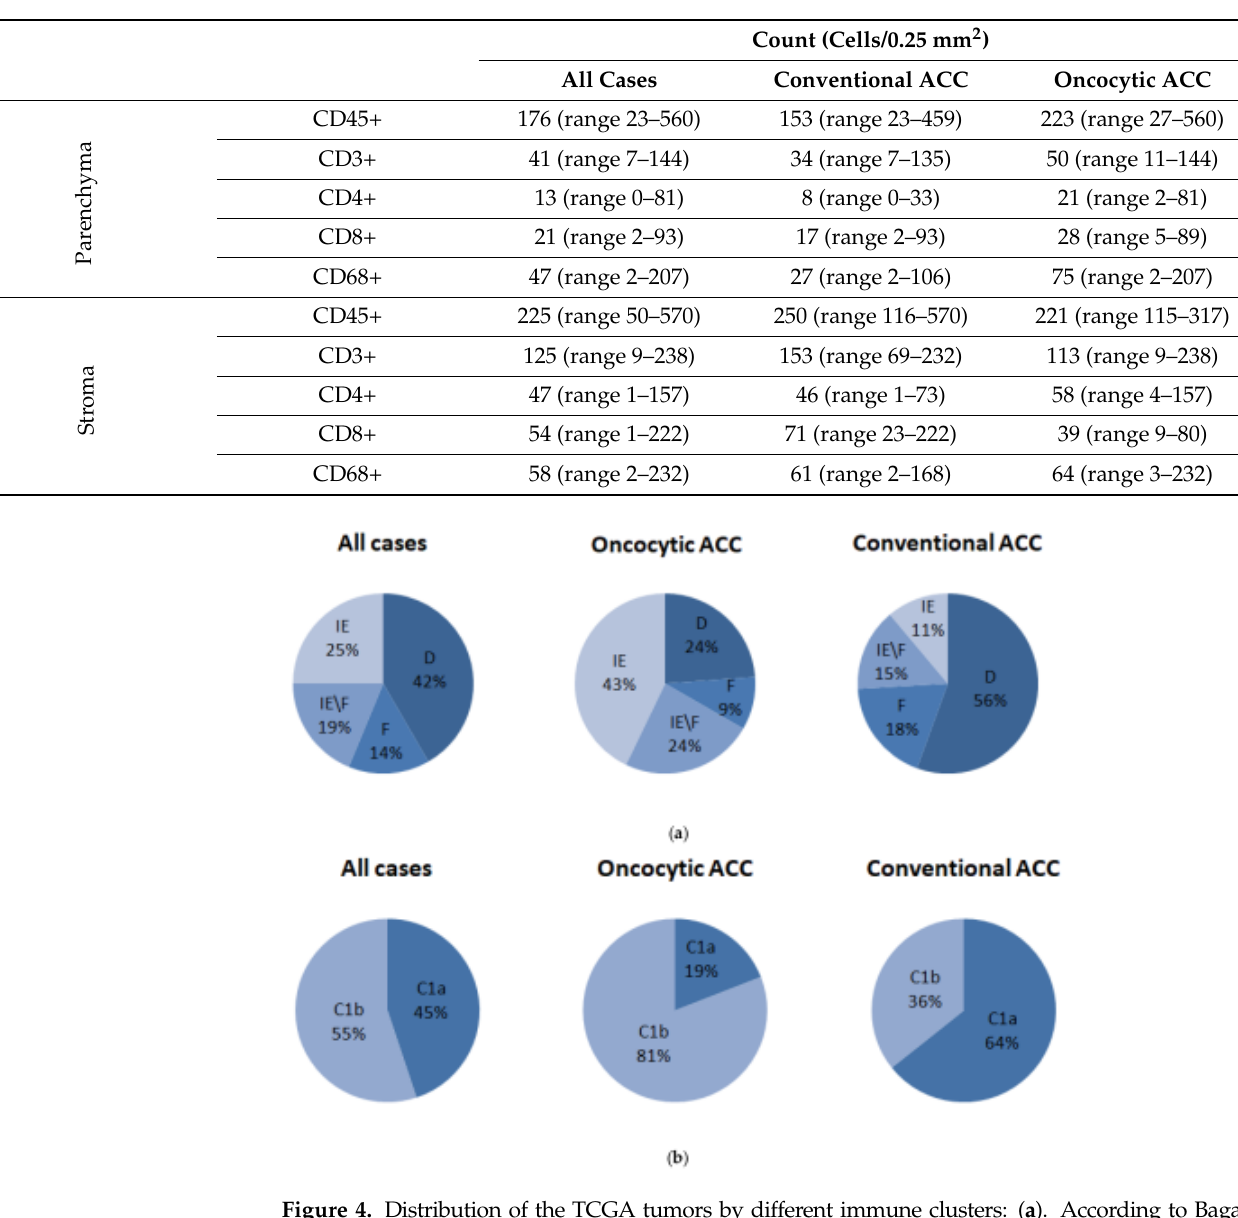
Figure 4. Distribution of the TCGA tumors by different immune clusters: ( a ). According to Bagaev et al. [41]: D—immune depleted, F—fibrotic, IE—immune enriched, IE/F—immune enriched, fibrotic samples; ( b ). According to Zheng et al. [40]: C1a—steroid-high, C1b—steroid-low/immune-high